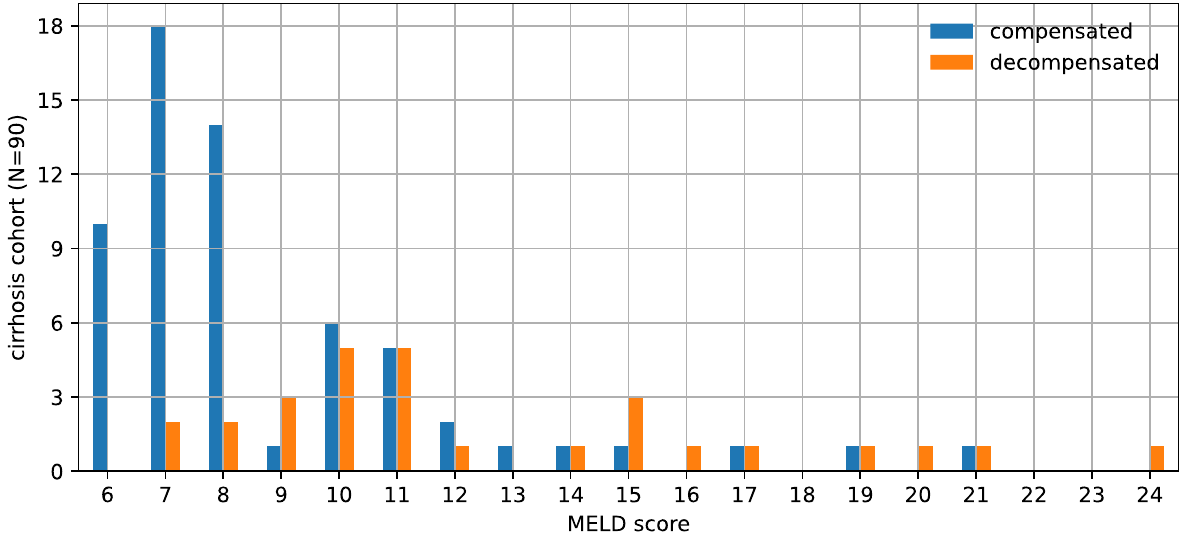
Figure 2. This histogram shows the distribution of the Model for End-Stage Liver Disease (MELD) score and decompensation status of the cirrhosis cohort. This cohort population is biased towards relatively milder liver disease. The imperfect correlation between MELD score and decompensation status is also evident from this chart.